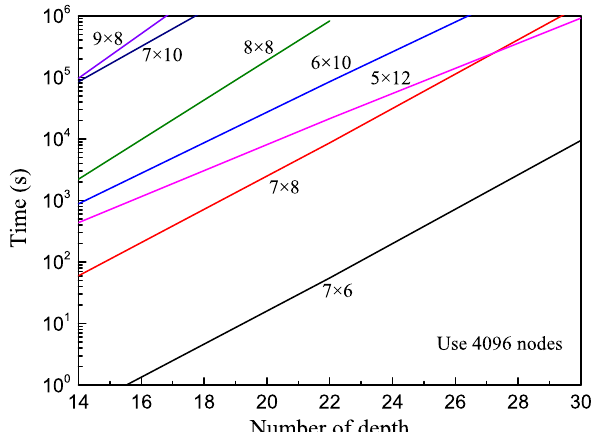
Figure 5. The time span of executing RQCs on the partial amplitude mode. The product of two numbers represents the total number of